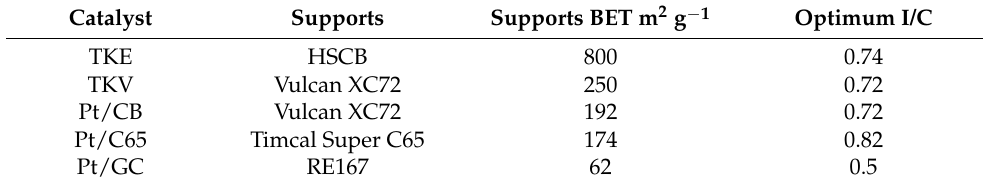
Figure 5. I–V characteristics of the membrane electrode assemblies (MEAs) at 150 kPA under cell operating temperature 80 °C, anode and cathode dew point 80 °C, inlets 84 °C, and anode and cathode stoichiometry 1.3 and 3, respectively. Table 3. Optimum ionomer to carbon ratio (I/C). Table 4. Voltages (in V) of the MEAs at defined load currents.